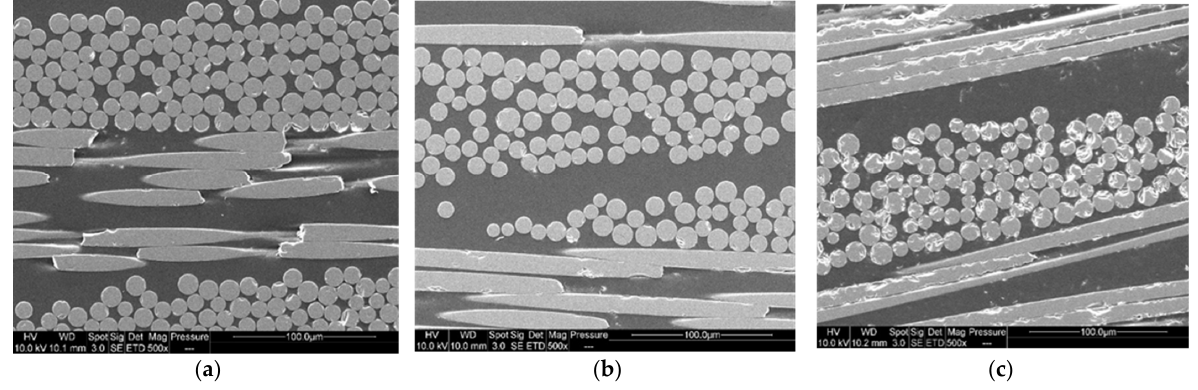
Figure 15. SEM images of ( a ) first generation composite ( b ) second generation composite after dissolution using mechanical stirring and ( c ) second generation composite after dissolution using ultrasound in the beginning.